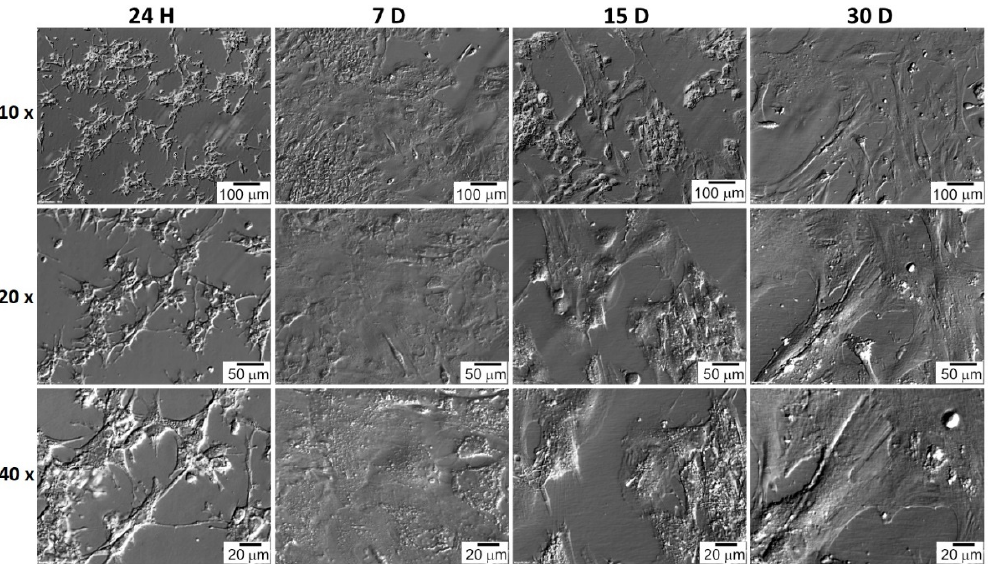
Figure 7. CC’s morphology over 30 days in vitro culture. H: hour of culture, D: day of culture.